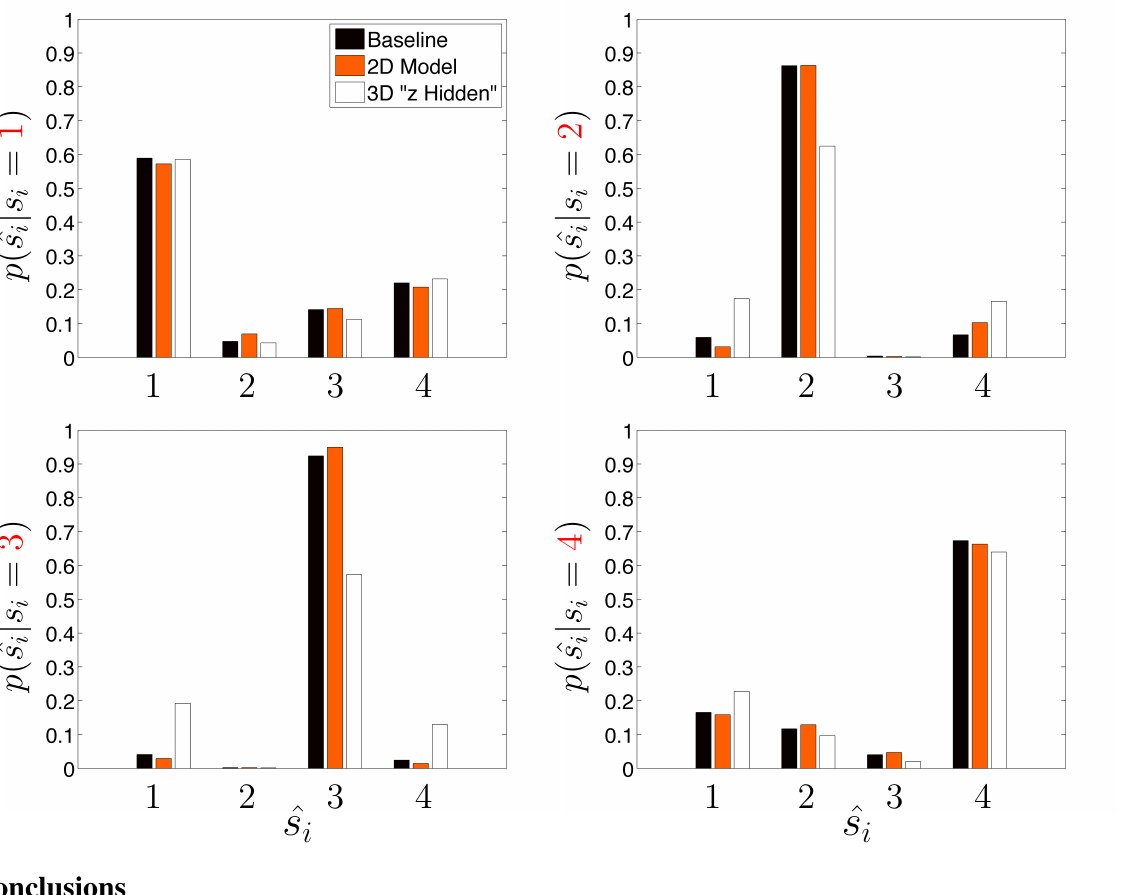
Figure 6. Same as Figure 5, except that effects of dimensionality of the underlying state model are investigated (see description in